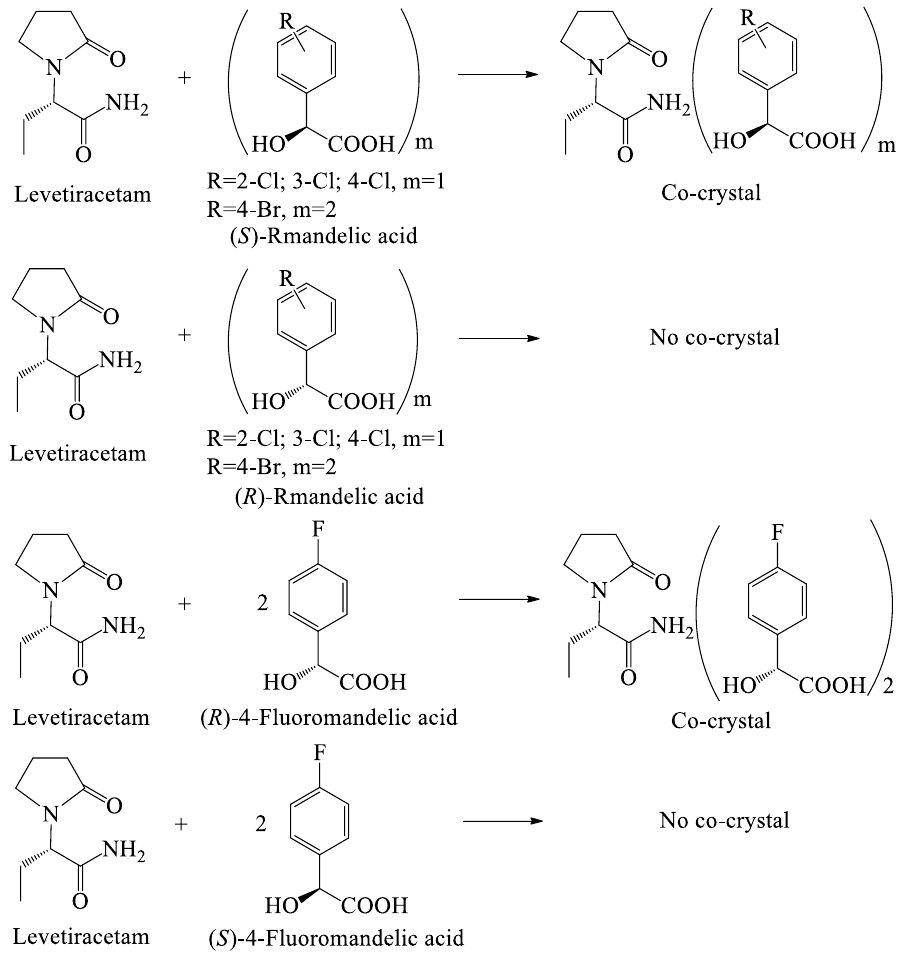
Figure 1. Enantiospecific co-crystal behavior between halogenated mandelic acid enantiomers and levetiracetam (LEV) [40].